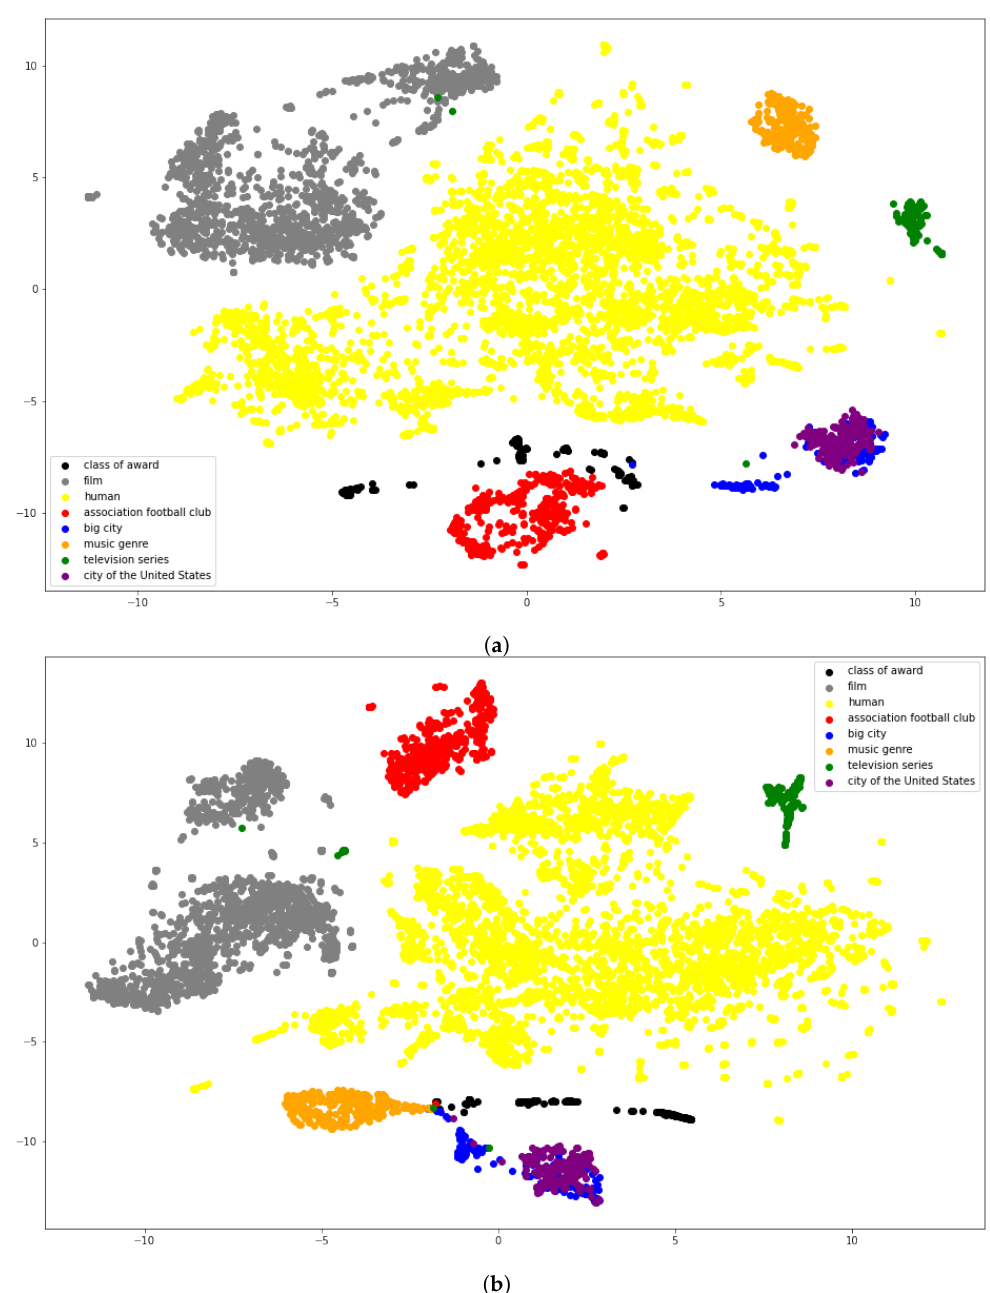
Figure 4. Clustering results of entity embeddings for ProtoEDistMult and DistMult. ( a ) ProtoEDist- Mult; ( b )